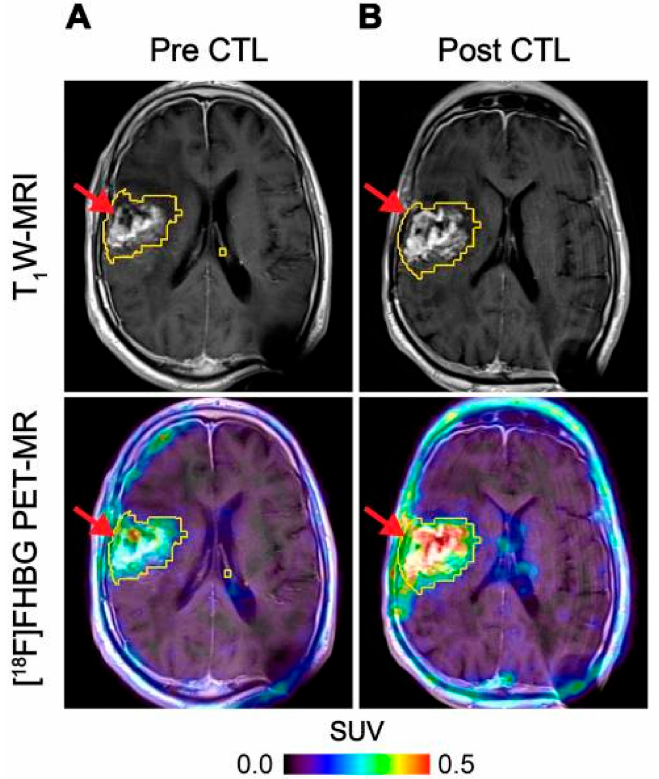
Figure 3. Imaging of HSV1-tk gene reporter expression in genetically modified CTLs with [ 18 F]FHBG. [ 18 F]FHBG-PET imaging was performed in a patient with recurrent glioblastoma multiforme tumour in the right frontoparietal lobe before ( A ) and 1 week after ( B ) CTL infusions. Allogeneic CTLs and IL-2 were injected intratumorally (red arrows). Tumour recurrence was monitored by T 1 -weighted (T 1 W) MRI (top panels) and [ 18 F]FHBG-PET images were fused with the MR images (bottom panels). A significant increase in [ 18 F]FHBG uptake and PET signal was detected following CTL infusion, which was likely to be due to CTL cell trafficking. Figure reproduced from [51].